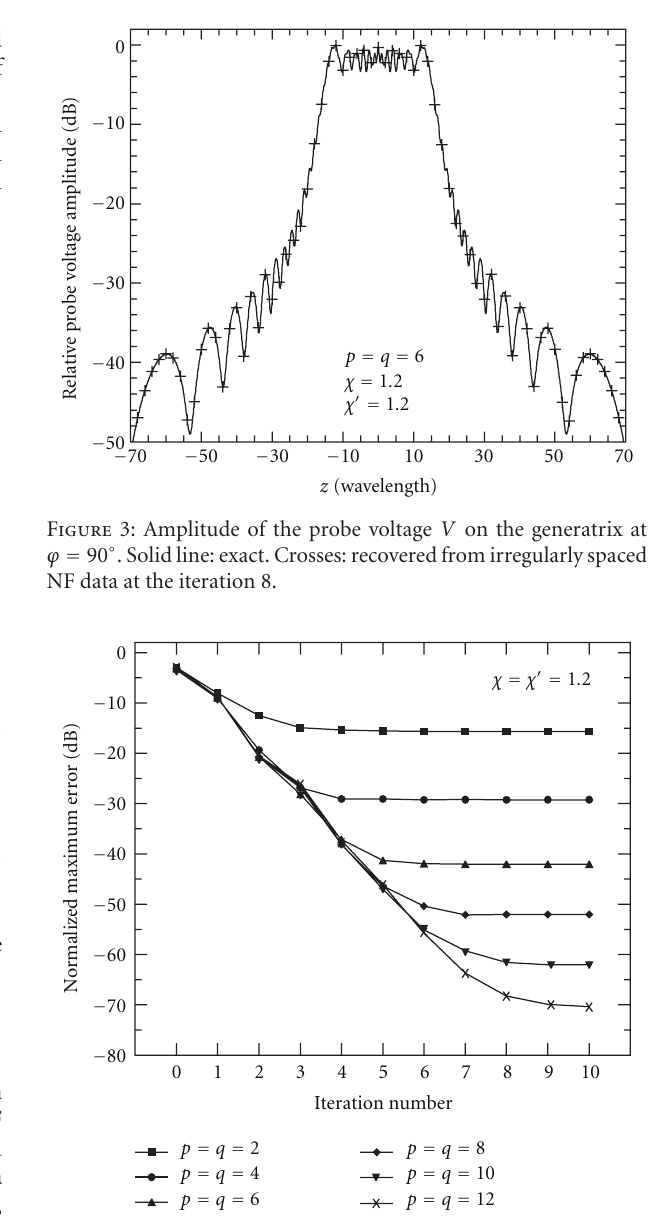
Figure 4: Normalized maximum error in the reconstruction of the uniform helicoidal